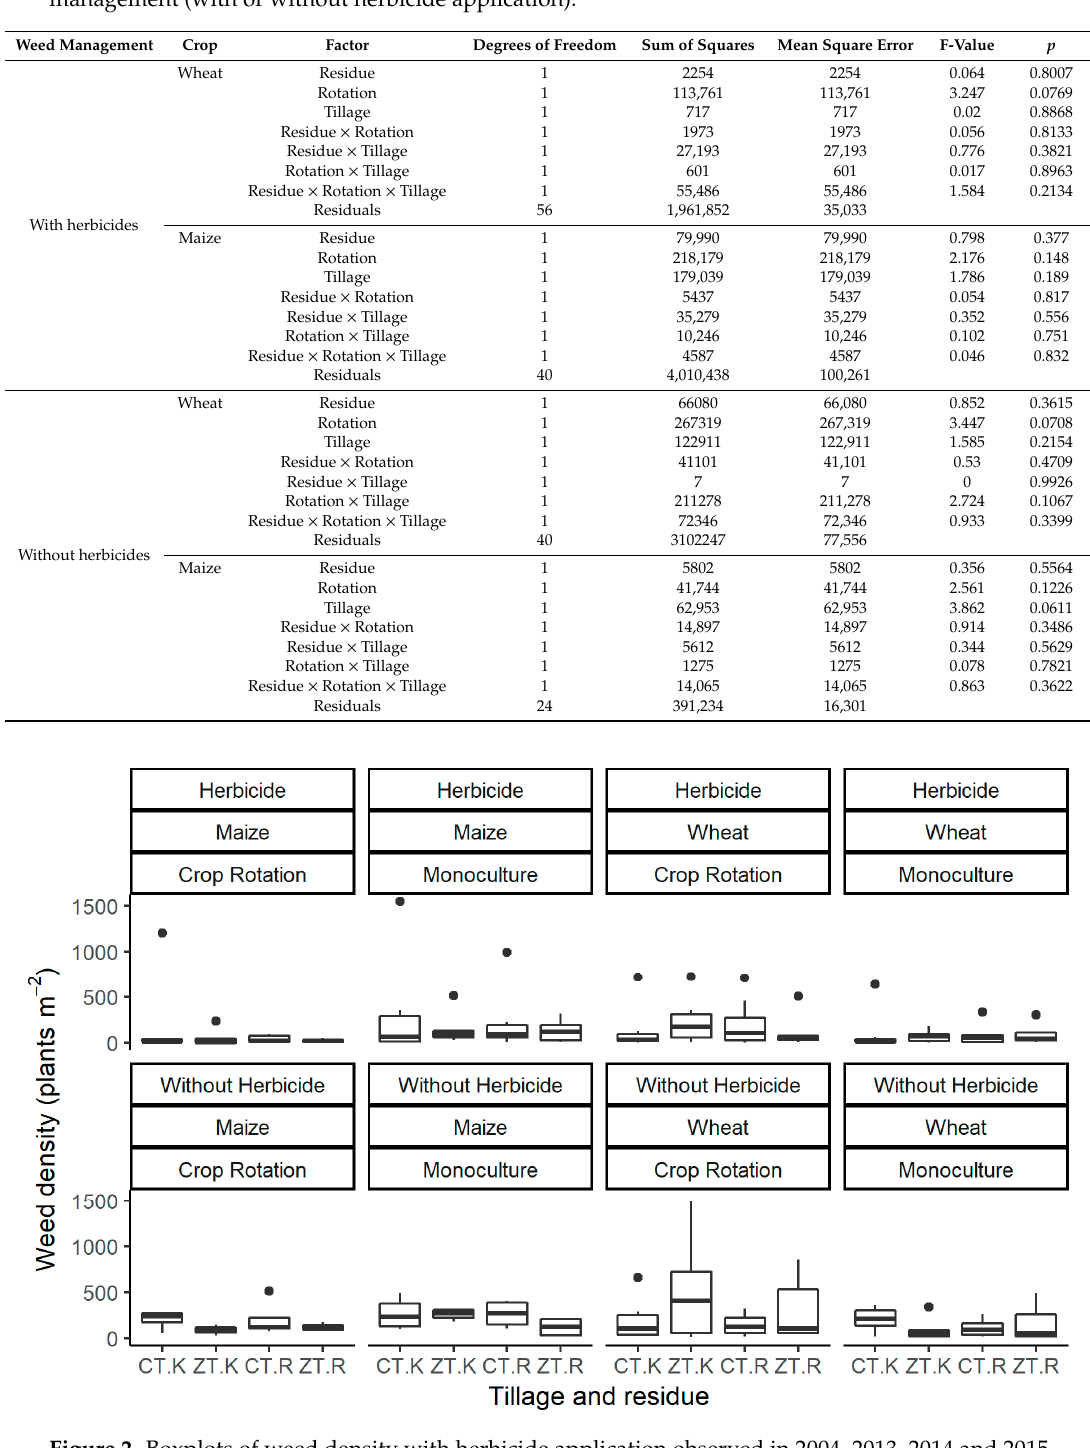
Table 5. Analysis of variance (ANOVA) of weed density per crop (wheat or maize) and per weed management (with or without herbicide application).